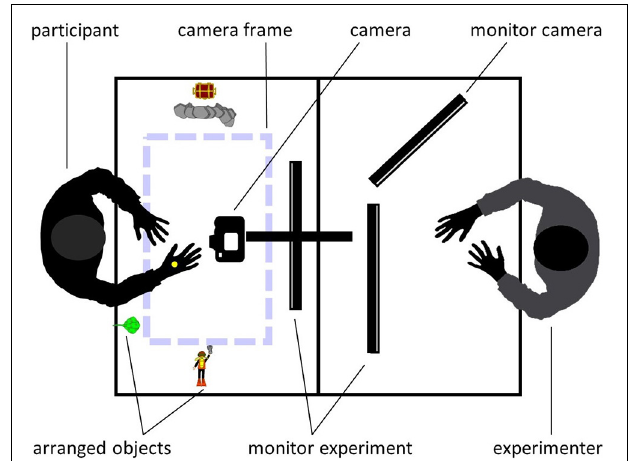
FIGURE 1 | Schematic overview of the filming setup during training sessions. Objects for each story were placed around the camera section (dashed lines). Trials were presented simultaneously for both, experimenter and participant. The participant’s imitation attempts were filmed using the above-mounted camera. The experimenter watched the participant’s performance during imitation trials on an additional